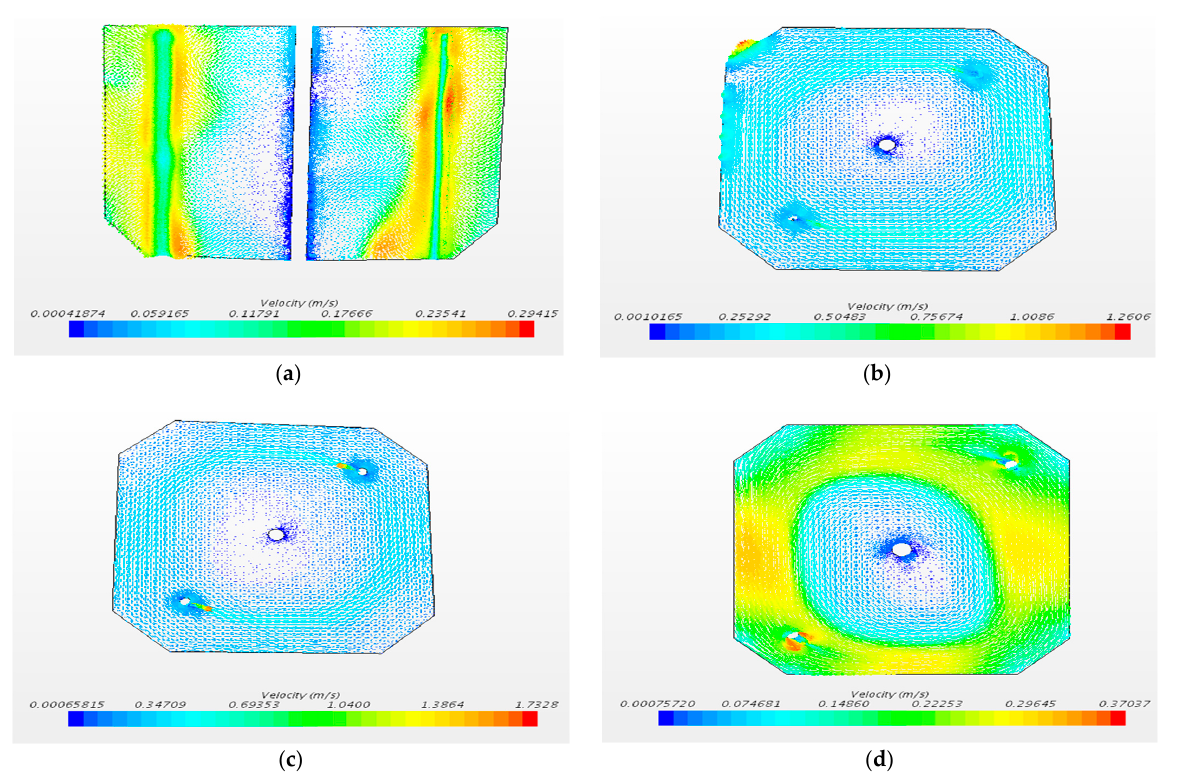
Figure 15. ( a ) middle longitudinal section, ( b ) H = 16.5 m cross section, ( c ) H = 8.5 m cross section, ( d ) H = 1.5 m cross section.